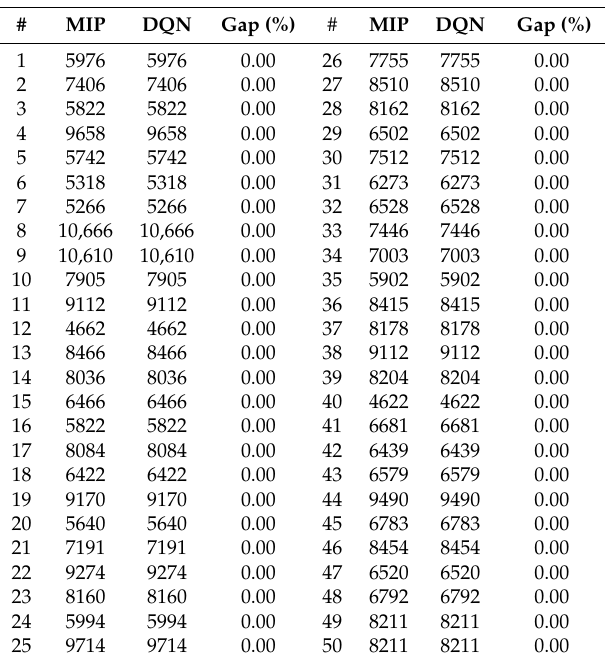
Table 2. Comparison on 50 2-train